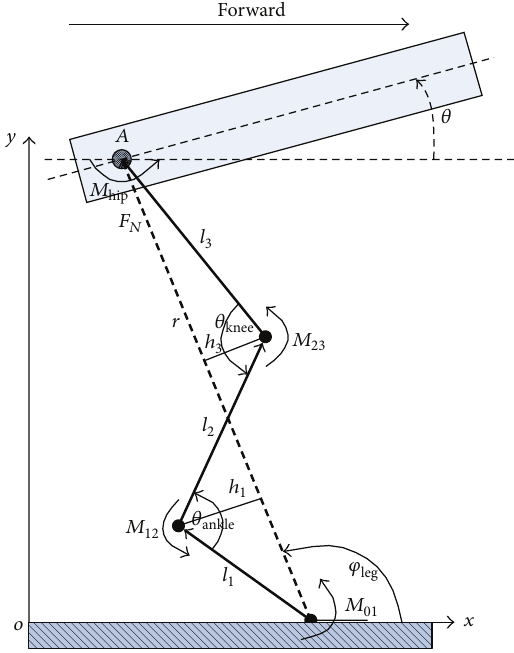
Figure 4: Force diagrams of the multi-joint